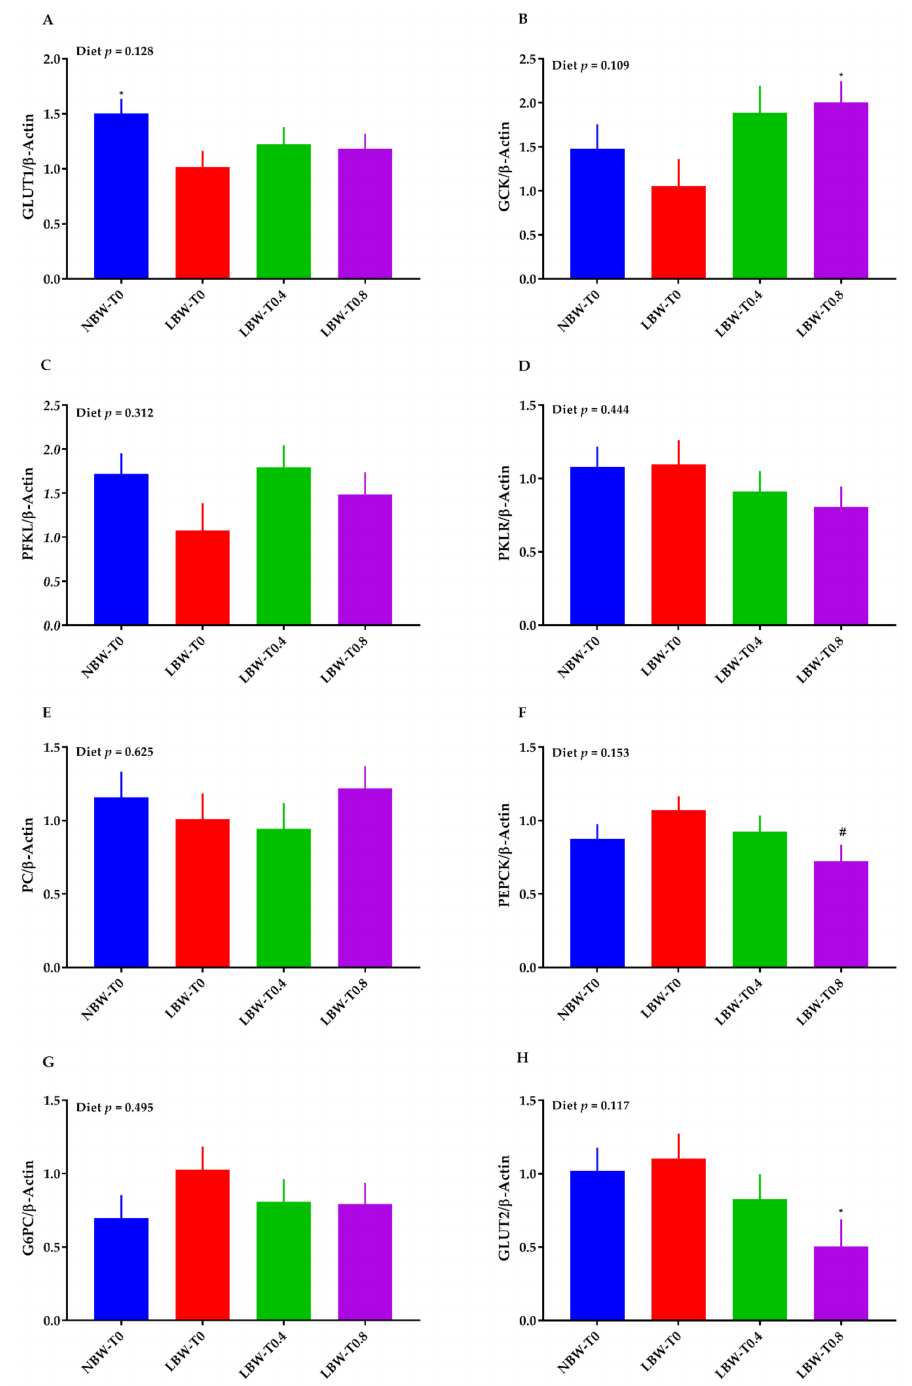
Figure 6. Effect of dietary L-tryptophan supplementation on the liver mRNA abundance of glucose metabolism markers in low-birthweight neonatal pigs. ( A ) glucose transporter 1 (GLUT 1), ( B ) glucokinase (GCK), ( C ) phosphofructokinase, liver-type (PFKL), ( D ) pyruvate kinase, liver, and RBC (PKLR), ( E ) pyruvate carboxylase (PC), ( F ) phosphoenolpyruvate carboxykinase (PEPCK), ( G ) glucose-6-phosphatase catalytic (G6PC), and ( H ) glucose transporter 2 (GLUT2). NBW-T0, normal-birthweight piglets fed a basal diet without supplemented L-tryptophan (Trp); LBW-T0, low-birthweight piglets fed a basal diet without supplemented Trp; LBW-T0.4, low-birthweight piglets fed a diet supplemented with 0.4% Trp; and LBW-T0.8, low-birthweight piglets fed a diet supplemented with 0.8% Trp. n = 8 for NBW-T0, LBW-T0, and LBW-T0.8, and n = 7 for LBW-T0.4. * p ≤ 0.05 vs. LBW-T0; # 0.05 < p ≤ 0.1 vs. LBW-T0. The values are the means ±